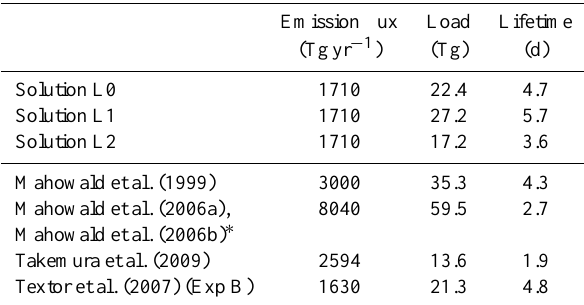
Table 1. Simulated global dust emission flux, atmospheric dust load and lifetime for present day from three solutions of climate system model compared to other studies.